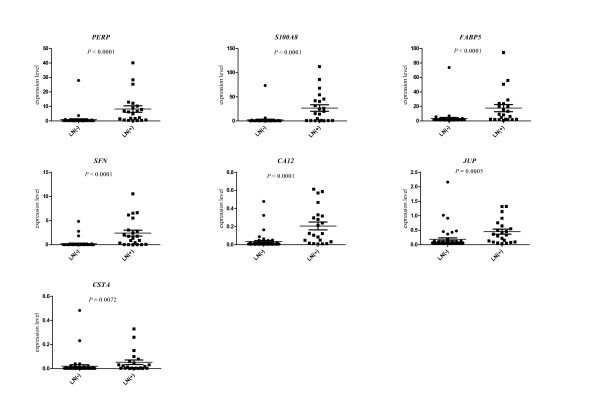
ThePERP,S100A8,FABP5,SFN,CA12,JUPandCSTAexpression levels in lymph node samples, measured by qRT-PCR. Abbreviations: LN(+) - involved lymph node, LN(−) - uninvolved lymph node sample, P – P value computed by the Wilcoxon test.